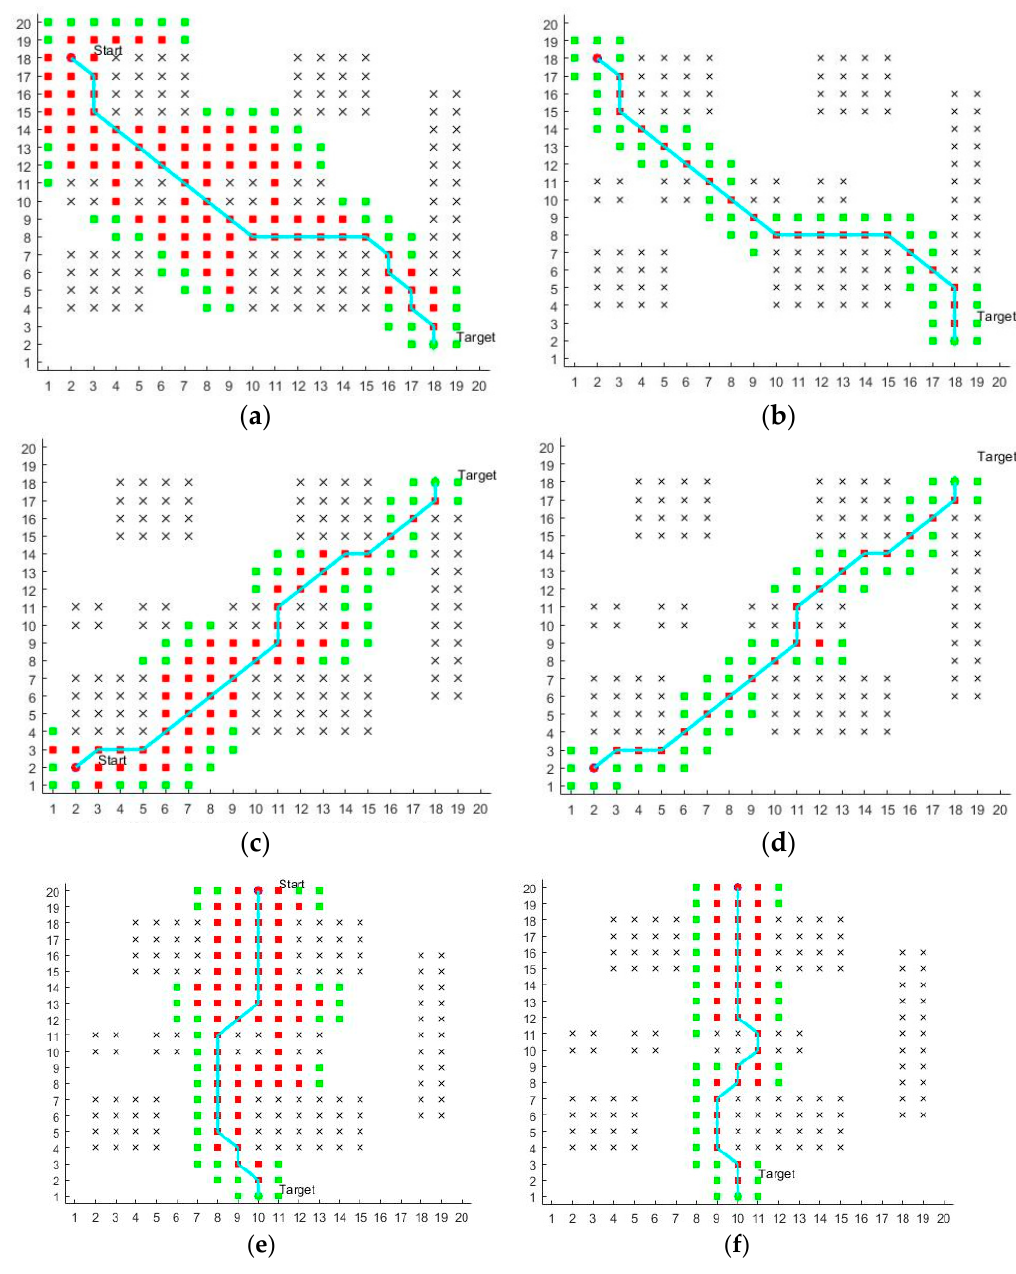
Figure 8. Global path comparison. ( a , c , e ) Traditional A-star algorithm; ( b , d , f ) optimization of the A-star algorithm. Table 2. Comparison of path-planning times before and after algorithm optimization (unit: s). Time